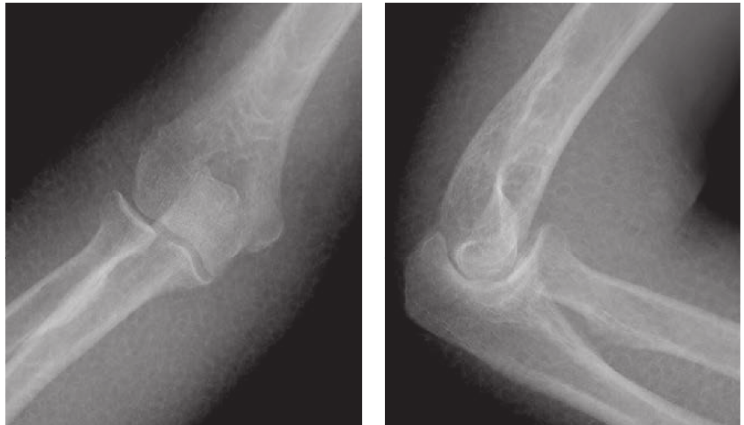
Figure 3: Postreduction radiographs revealed no